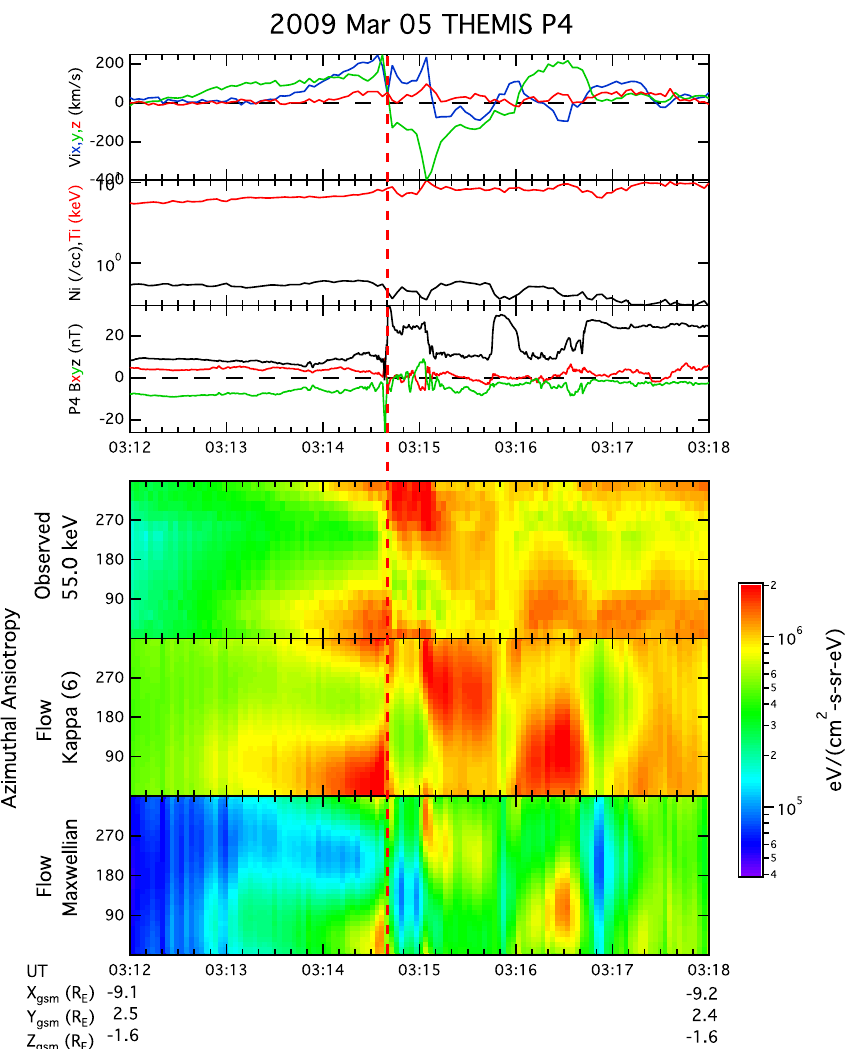
Fig. 6. Observations of the current disruption/dipolarization event on 5 March 2009. The parameters shown and the format are same as Fig. 2.